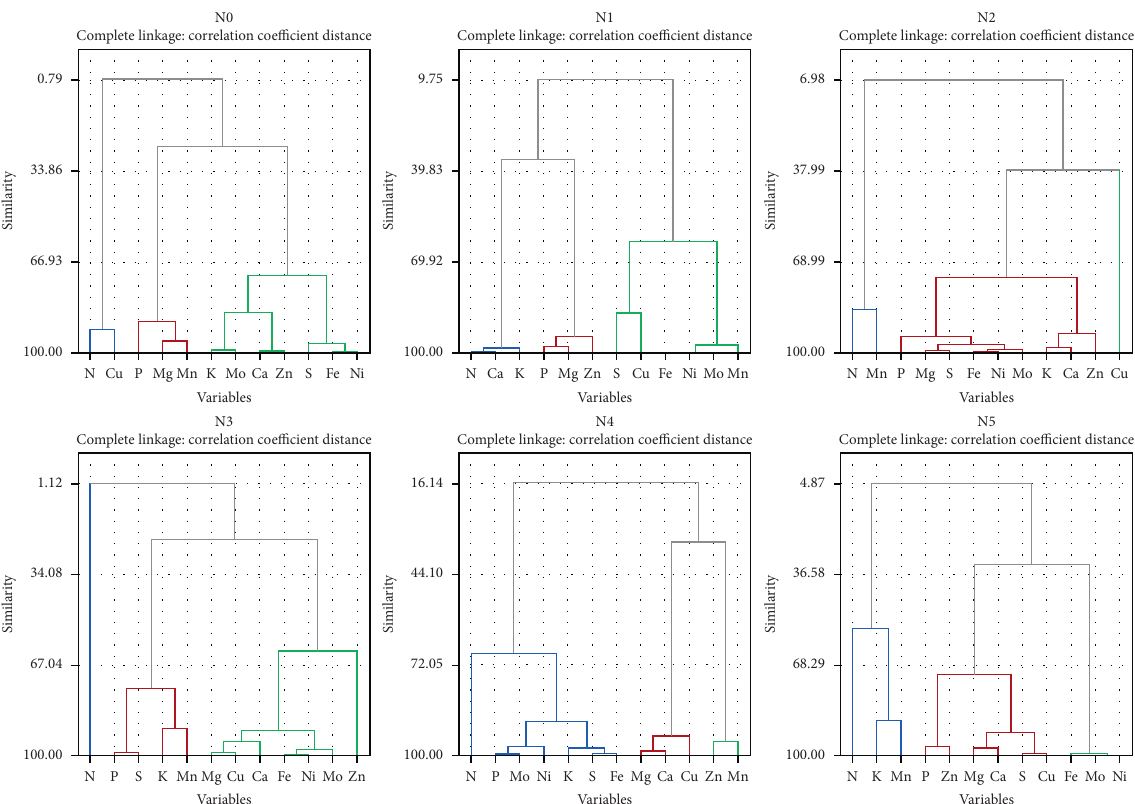
Figure 6: Cluster of NPK in nutrients of cob. Nitrogen (N), potassium (K), phosphorus (P), magnesium (Mg), calcium (Ca), sulphur (S), zinc (Zn), iron (Fe), copper (Cu), manganese (Mn), nickel (Ni), and molybdenum